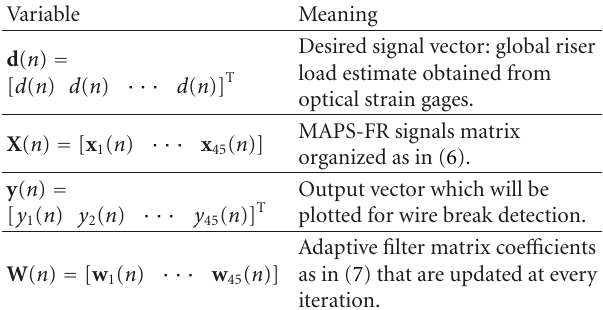
Table 4: Hybrid algorithm